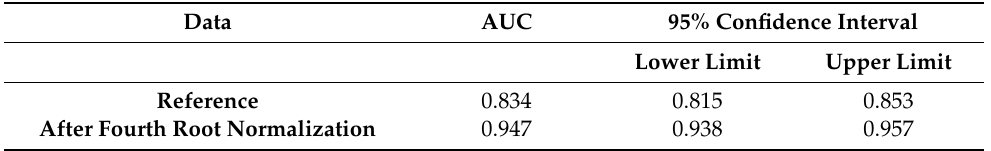
Figure 4. ROC curves representing the accuracy of the reference data (blue line; AUC = 0.834) and after fourth root normalization (red line; AUC = 0.947). The green diagonal line corresponds to the reference AUC = 0.5. Table 2. The generated AUCs and the 95% confidence interval for both the reference data and after fourth root normalization.